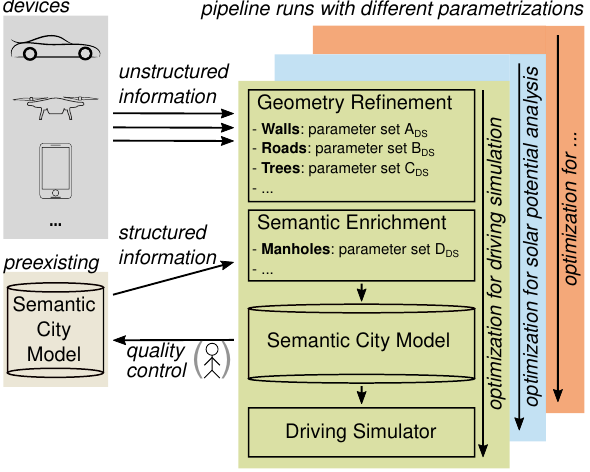
Figure 1. Overview of the pipeline concept, whereas DS denotes the application driving